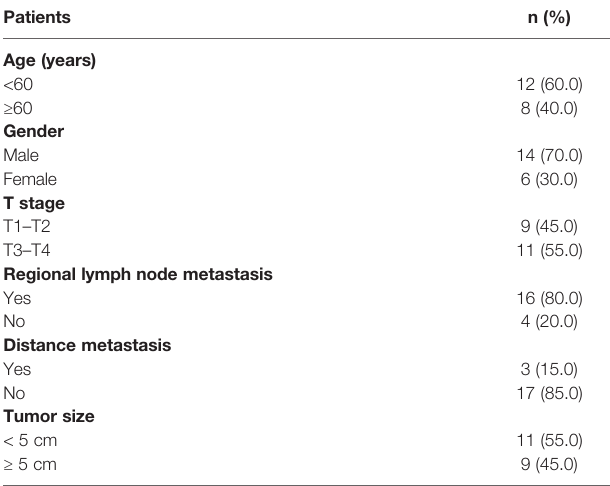
TABLE 1 | Clinicopathological features of HCC patients (n = 20).